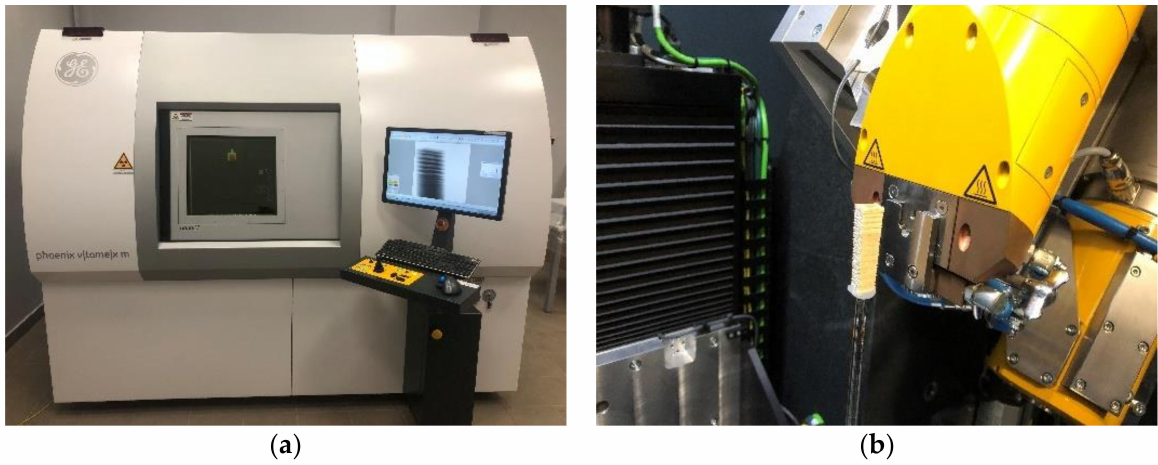
Figure 8. X-Ray CT studies. ( a ) GE Phoenix v-tome-x m device performing a test; ( b ) Sample prepared for a tomography test positioned inside the device.